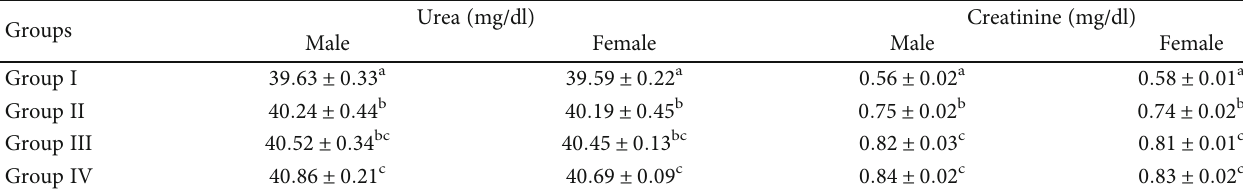
Table 2: Serum urea and creatinine level of the groups of the male and female mice.